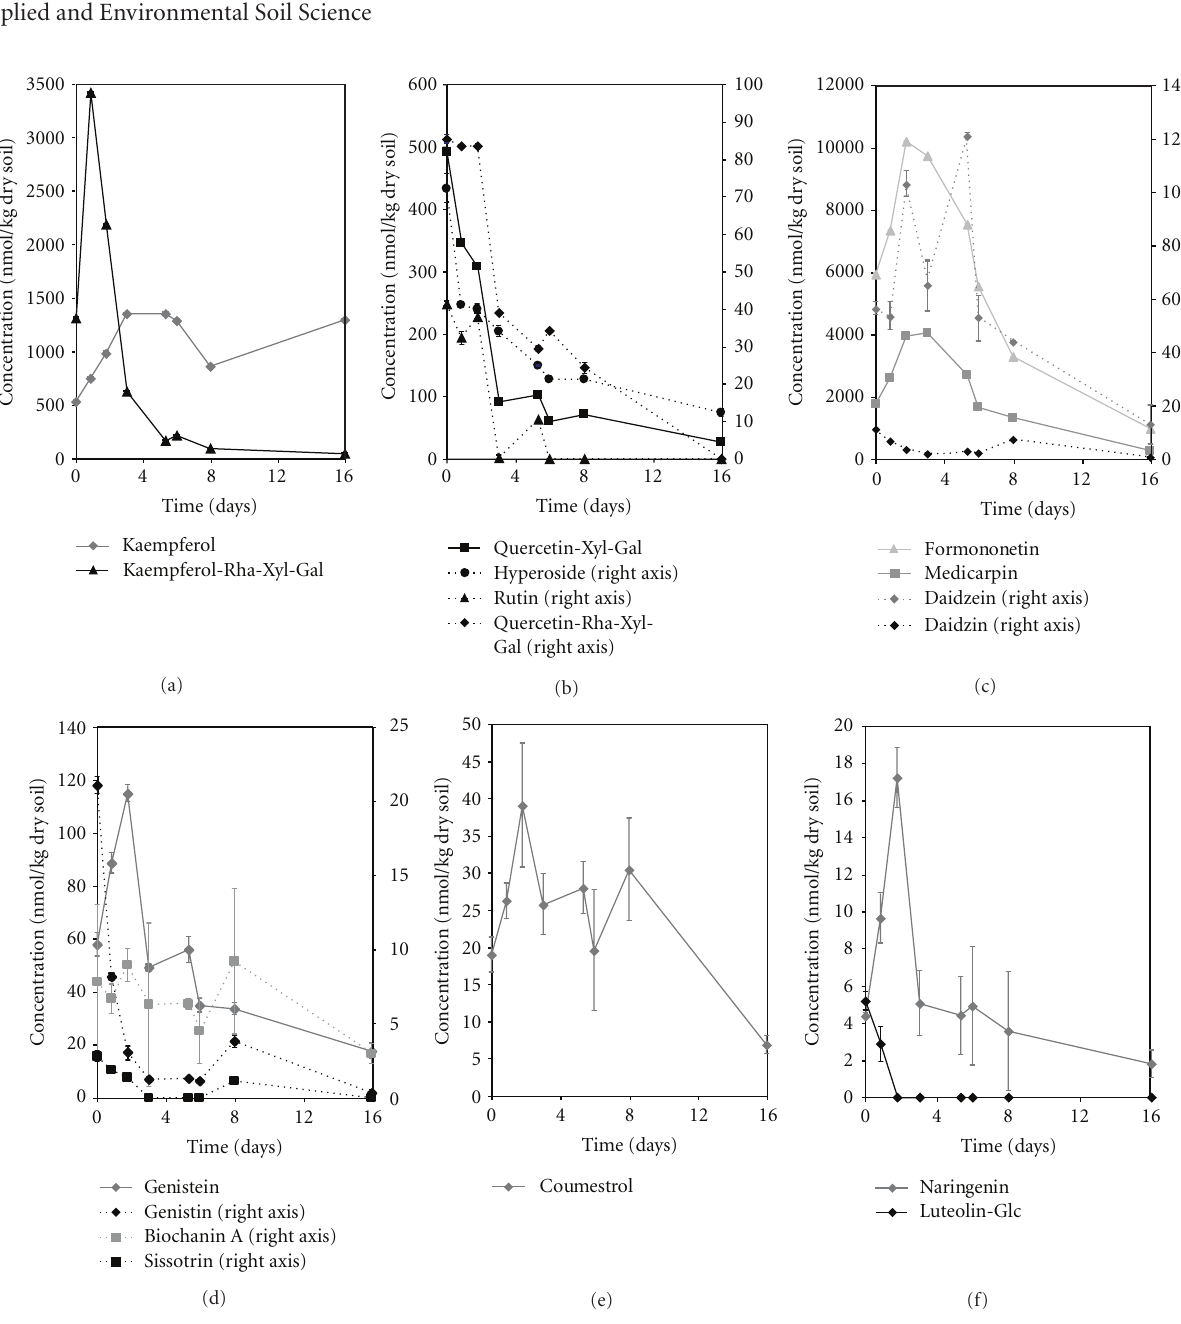
4.3. Fate of Flavonoids in Soil Amended with White